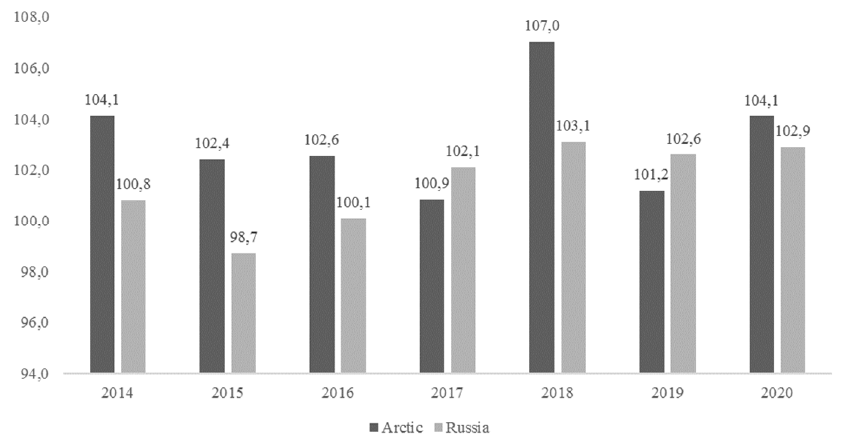
Figure 2. Labor productivity index dynamics, percentage (compiled by authors).